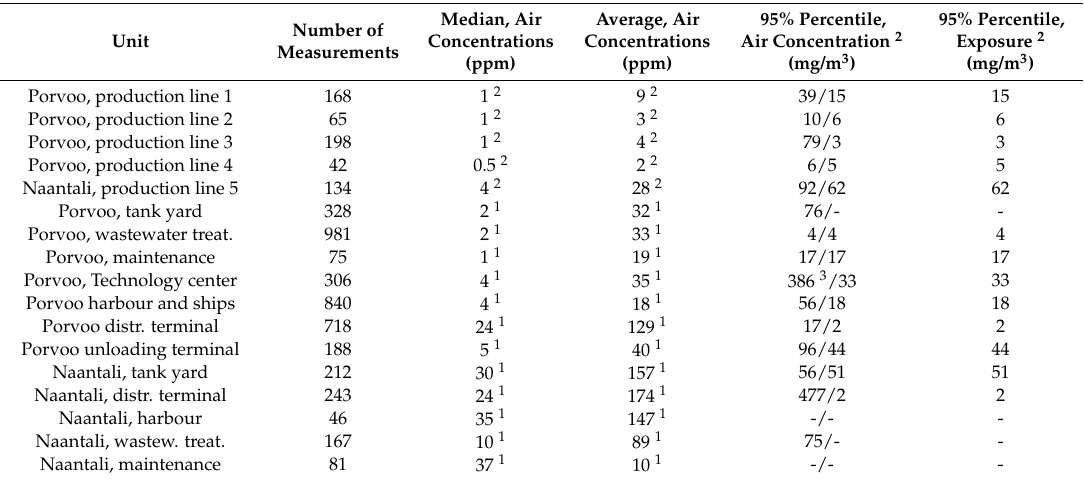
Table 5. Development and end points of hydrocarbon air concentrations and end points of hydrocarbon exposure. 95% Percentile, Average, Air Median, Air Number of Concentrations Air Concentration 2 Concentrations Unit Measurements (mg/m 3 ) (mg/m 3 ) (ppm) (ppm) Porvoo, production line 1